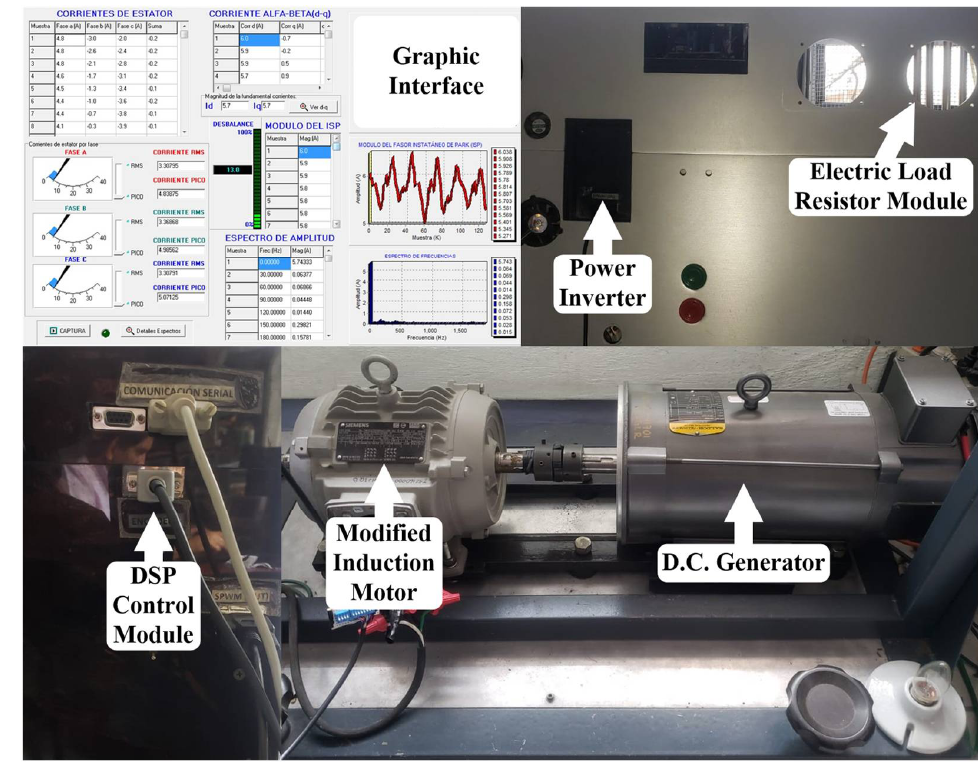
Figure 6. Experimental setup.